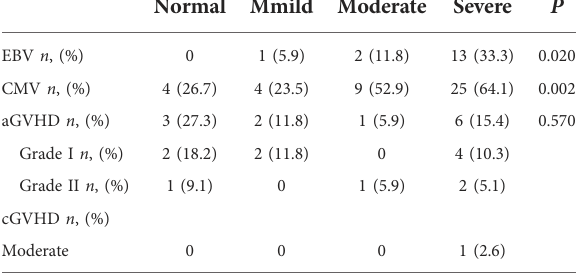
TABLE 3 Incidence of infection and GVHD in each group after HSCT. EBV and CMV infections were treated with ganciclovir or Normal Mmild Moderate valganciclovir, and most patients had a favourable prognosis. One EBV patient developed lymphoproliferative disease. By reducing the immunosuppressant dose, rituximab and ganciclovir therapy, the patient was cured.